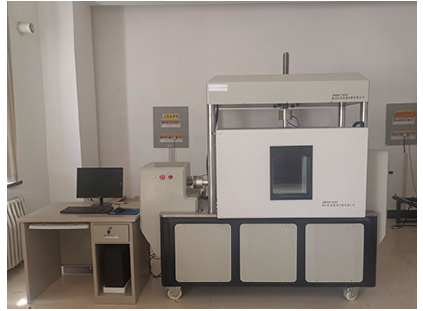
Figure 1. YT1200S direct shear pullout friction instrument for geosynthetics.